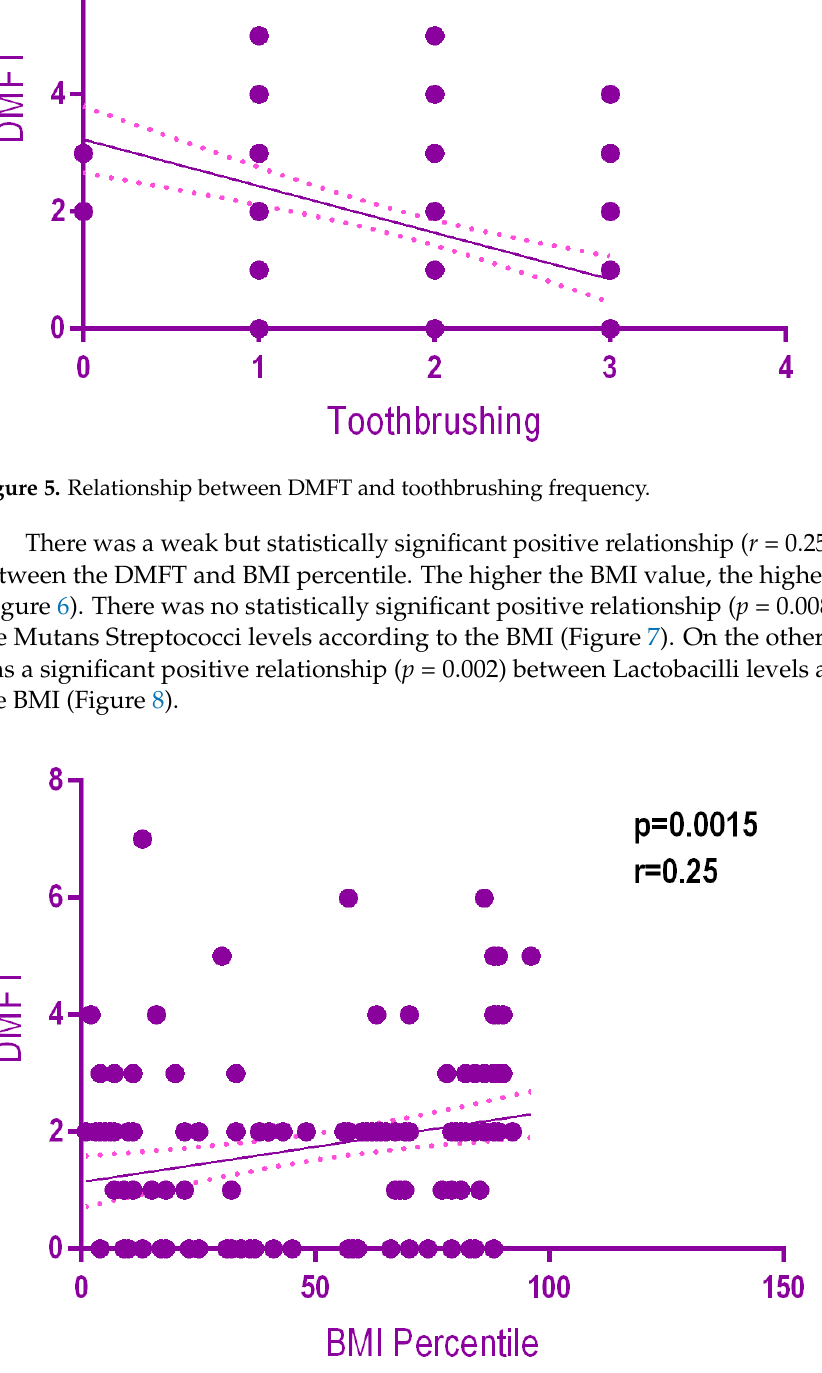
Figure 7. Mutans Streptococci levels according to the BMI. Figure 8. Lactobacilli levels according to the BMI. The results showed a significant association between the high presence of MS (high) ( p = 0.0083), and LB (high) ( p = 0.0002) and an increased BMI percentile. Overweight pa- tients have a higher level of MS and LB than normal or underweight patients.